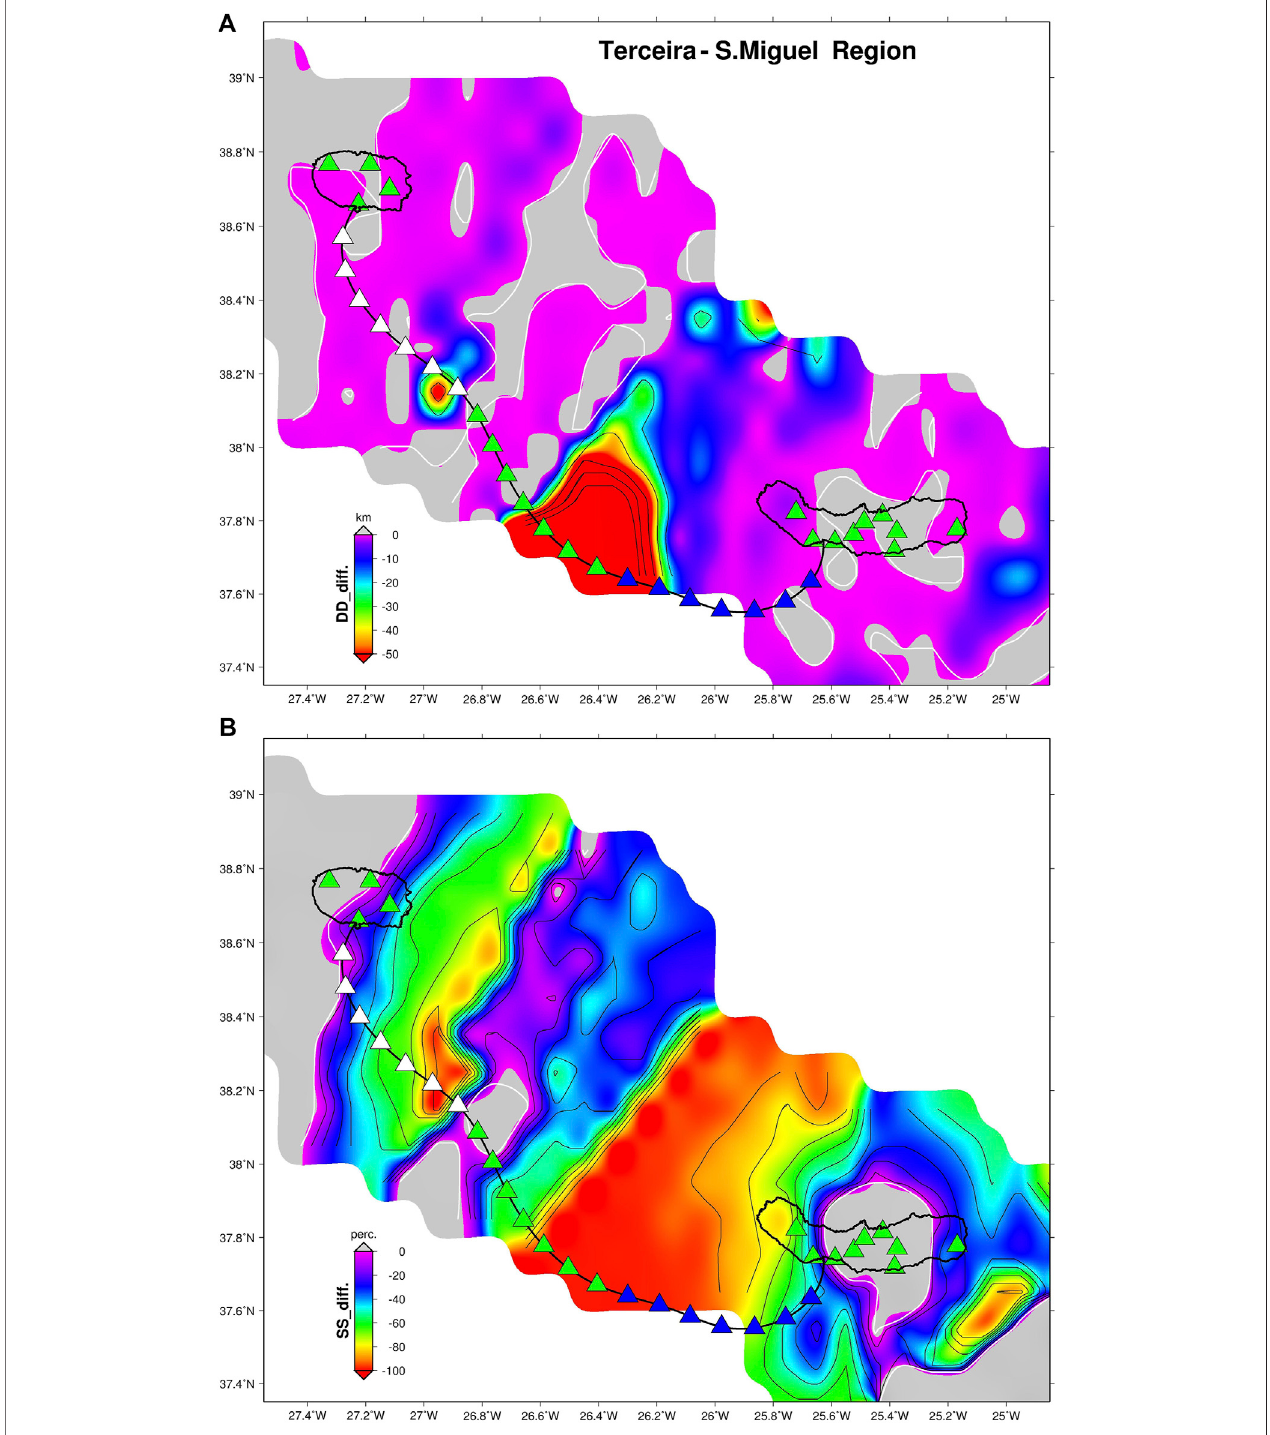
FIGURE 9 | Measure of the added value of the DAS to the earthquake fast parameter determination using Monte-Carlo simulations. Green triangles show the land seismicstationswhilethecabledstationsareshownasbluetriangles. (A) Differencebetween “ landpluscabled ” andlandonlynetworksfortheDDqualityparameter. (B) Differencebetween “ landpluscabled ” andlandonlynetworksfortheSSqualityparameter,in%.Onbothimagesredareasshowthedomainswerethedifferenceisless than the maximum value, light grey areas show the domains were no improvement was observed.